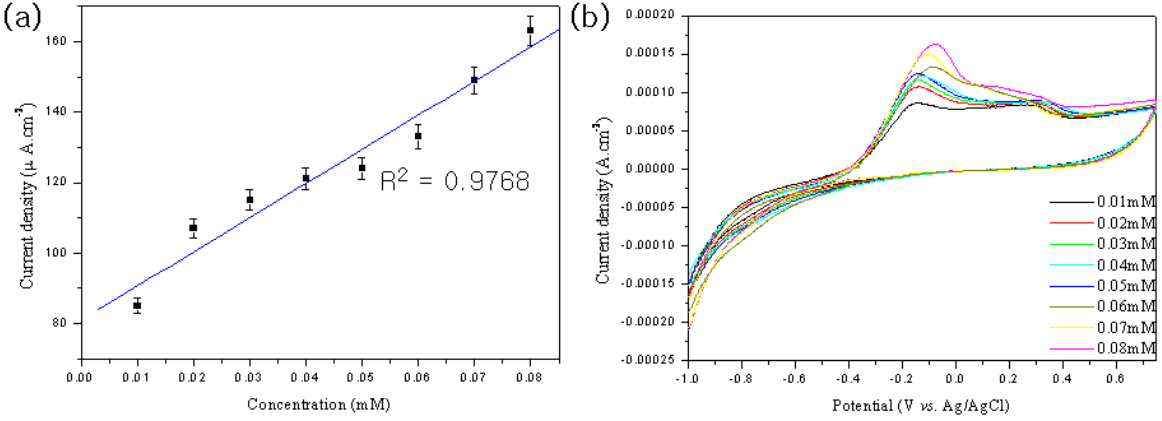
Figure 7. Cyclic voltammograms of MWNT ion liquid electrode based on tyrosinase in 2.0 mL phosphate buffer solution (pH = 7.0) containing 0.01~0.08 mM phenol (a), (b).